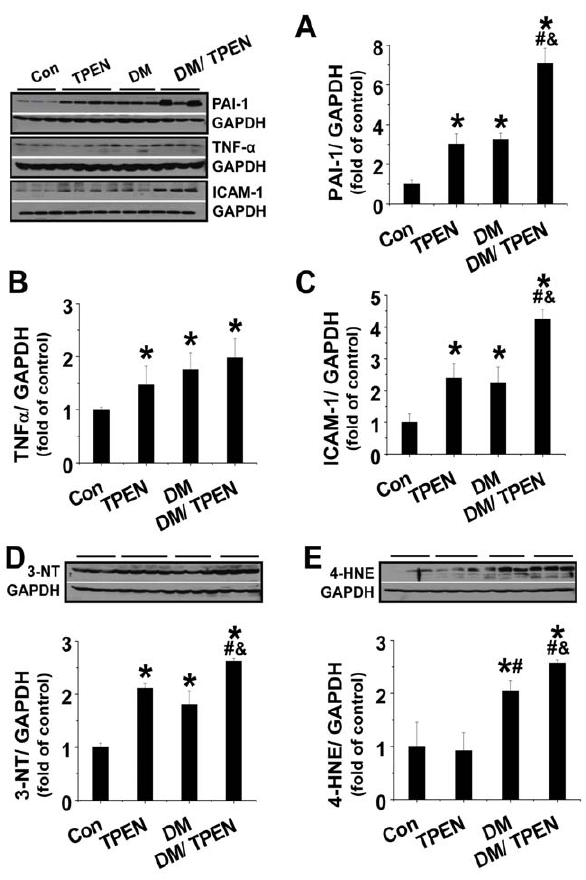
Figure 5. Diabetes and TPEN treatment decreased the expres- sion of Nrf2 that was associated with decreased Akt and GSK- 3 b phosphorylation and nuclear accumulation of Fyn. The expression of Nrf2 (A) and total and phosphorylated Akt (B) and GSK3 b (C) were examined with Western blotting. The expression of Fyn in nuclei, cytosol, and total tissues were measured by Western blotting, for which the ratios of Fyn-N/Fyn-T (D) and Fyn-C/Fyn-T (E) were presented. Data are presented as mean 6 SD (n=6 at least in each group). DM: diabetes; Fyn- N: Nuclear Fyn; Fyn- C: cytosolic Fyn; Fyn- T: Total tissue Fyn. * P , 0.05 vs. control group; # P , 0.05 vs. TPEN group; & P , 0.05 vs. DM group.